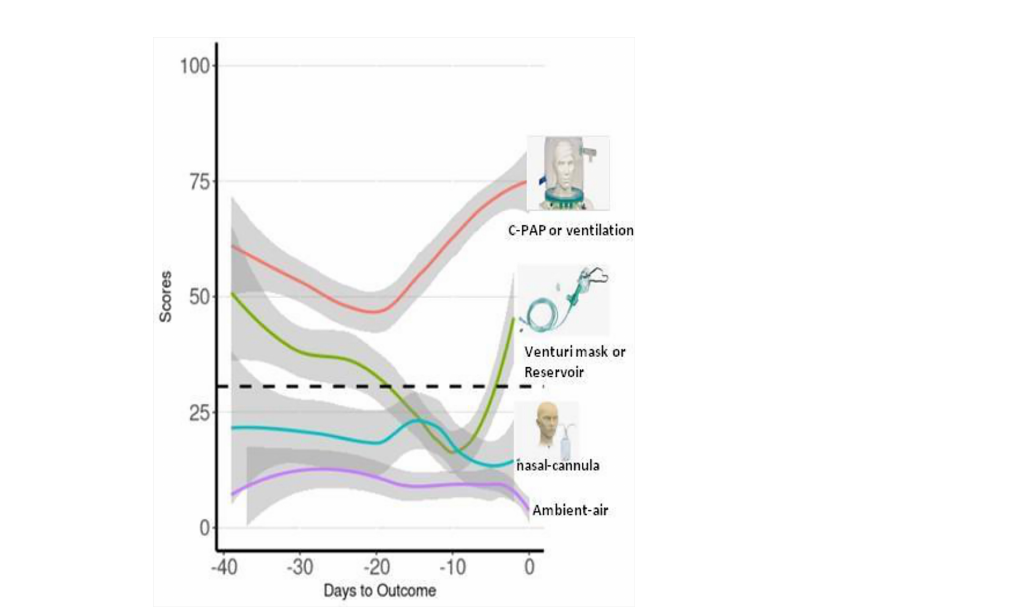
FIGURE 3 | Moving averages of median of score progression over time across severity groups for the assessment of the score values with the severity of patients based on the OXY therapy. Trend lines represent all the time points score measured in patients of the validation cohort according to the OXY therapy. Red line is for “ critical ” OXY therapy, which is continuous positive airway pressure (CPAP) or mechanical ventilation; green line is for “ severe ” OXY therapy, which is Venturi mask or reservoir mask; light blue line is for “ moderate ” OXY therapy, which is nasal-cannula; and purple line is for absence of OXY therapy, which is “ mild ” .